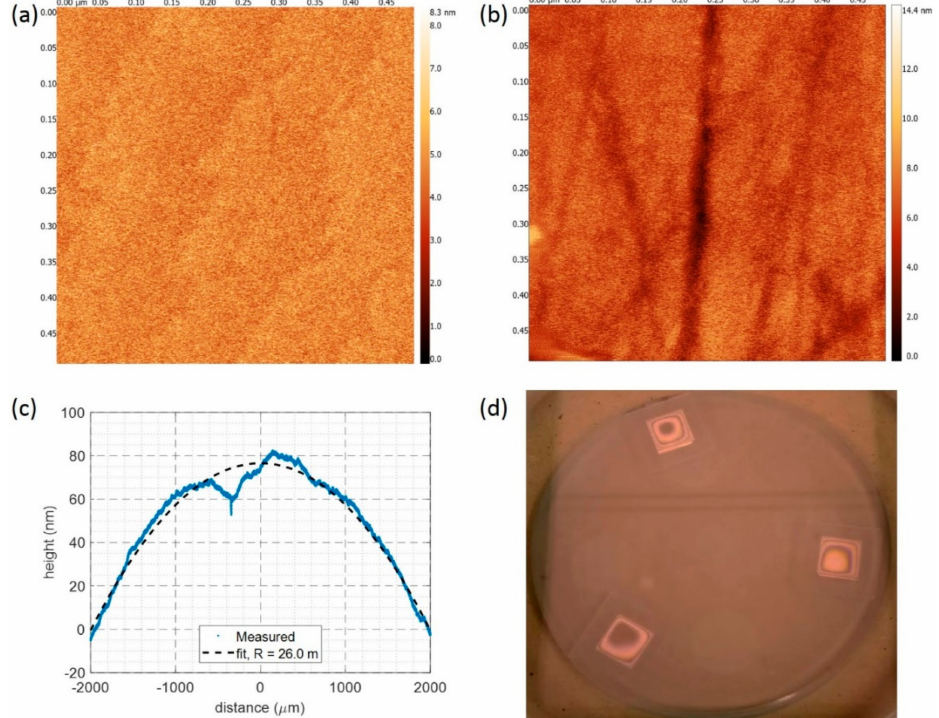
Figure 9. Atomic force microscope (AFM) measurements on a 0.5 µ m × 0.5 µ m area ( a ) KY(WO 4 ) 2 sample that was polished for two hours, with root mean square (RMS) roughness of 0.88 nm, and ( b ) an as-received sample with RMS roughness of 1.41 nm. ( c ) Measured surface profile of a KY(WO 4 ) 2 sample after two hours of polishing (blue). The measurement was carried out using a Dektak profilometer. The dashed line shows the quadratic function fit with a radius of curvature of 26.0 m. ( d ) Newton rings on the same polished samples, illuminated with a sodium lamp through an optical flat, demonstrating the high uniformity of the